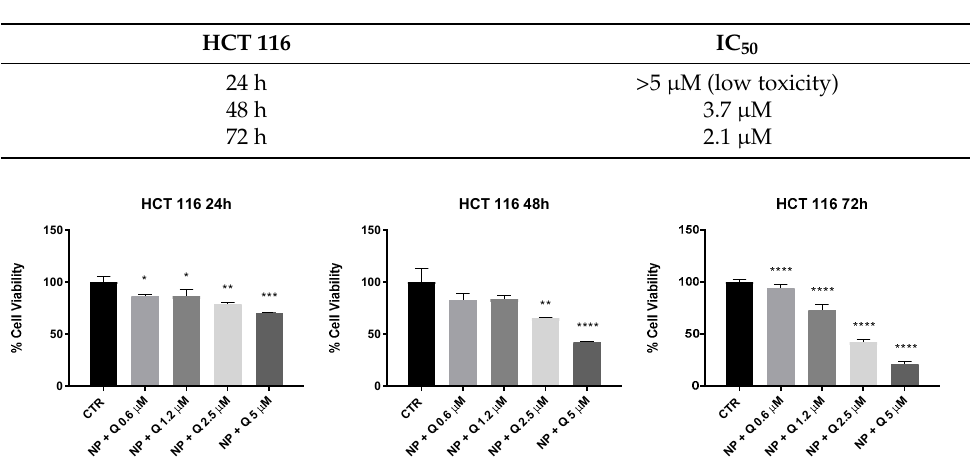
Figure 7. Effect of NP+Q on HCT 116 (colon cancer cell line) after 24 h, 48 h and 72 h, evaluated by MTT assay and expressed as percentage of cell viability (compared to untreated cells). Data are reported as mean of three independent experiments ± SD. (* p < 0.05; ** p < 0.005; *** p < 0.001; **** p < 0.0001 vs. negative control).